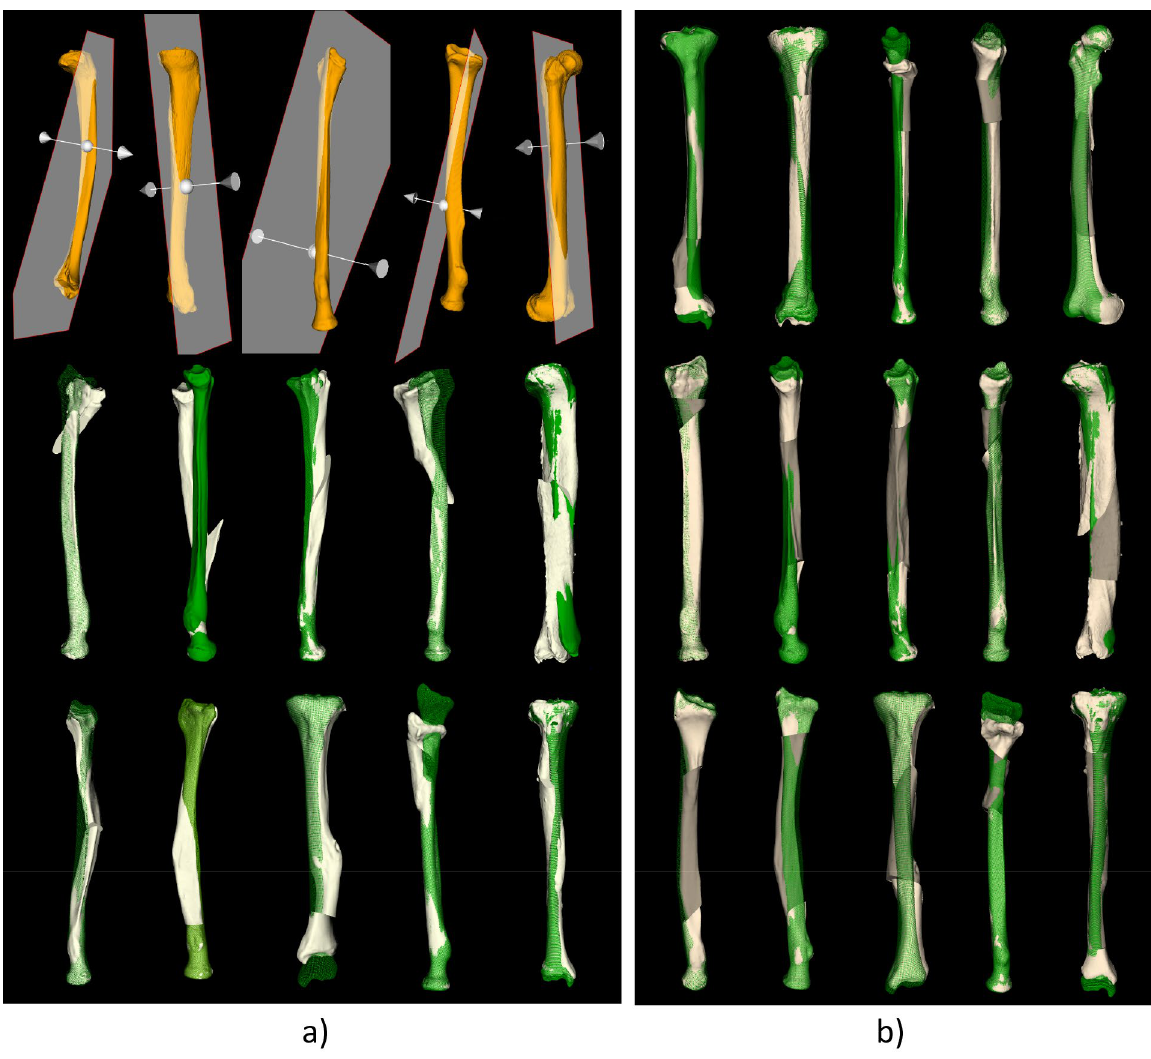
Figure 8. ( a ) Result of an oblique single cut rotation osteotomy (OSCRO) shown in white in comparison to the target bone (green). The top row shows cases where the osteotomy is too steep for clinical utilization. The remaining cases show perfect rotational alignment of the distal articular surface but a residual translation error and sometimes a large irregularity at the osteotomy location. ( b ) Resulting bone segments after an oblique double-cut rotation osteotomy (ODCRO) proximally aligned with the target bones (green) after running the optimization procedure balanced for length and transverse alignment (a = b = 0.5), 50% of bone overlap ( δ d , δ p ), maximum plane angulation ( α max ) 80